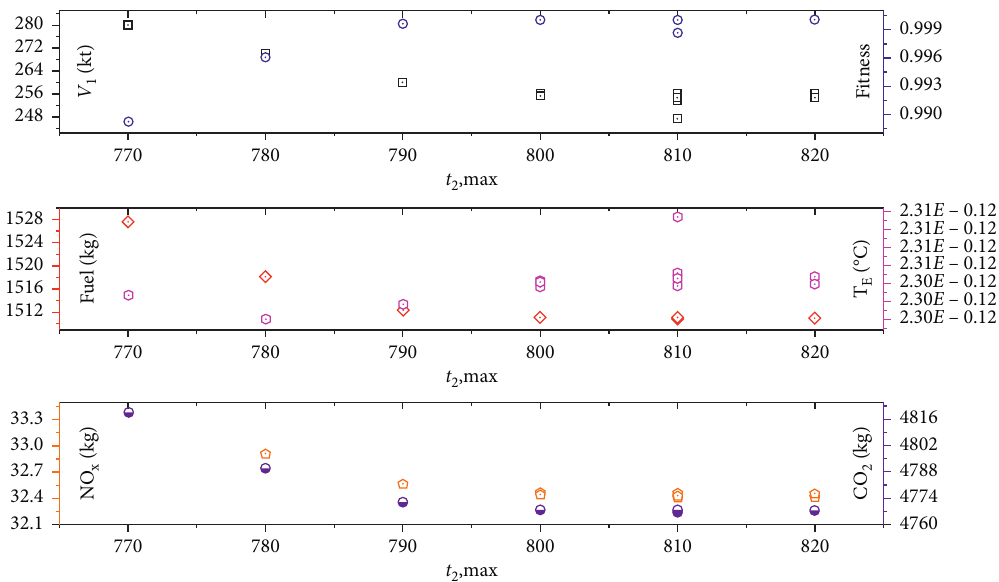
Figure 12: The influence trend of t